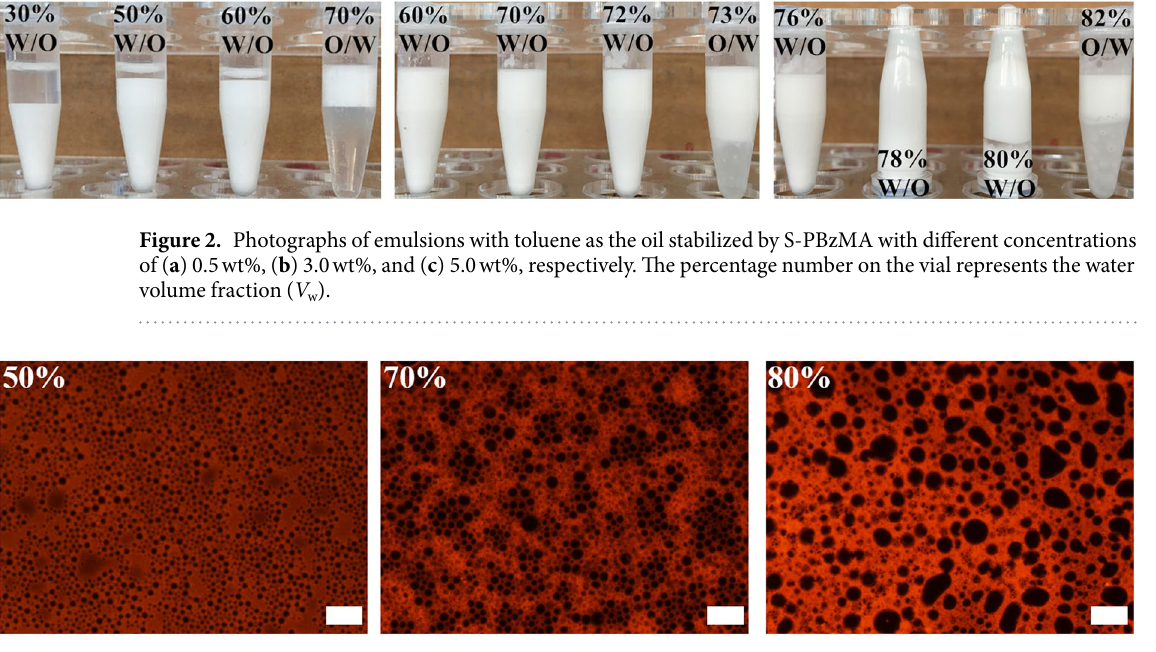
Figure 3. Fluorescence microscopy of emulsions stabilized by 5.0 wt% S-PBzMA with styrene as the oil. The percentage numbers are V w of the emulsions and the scale bars are all 50 μ